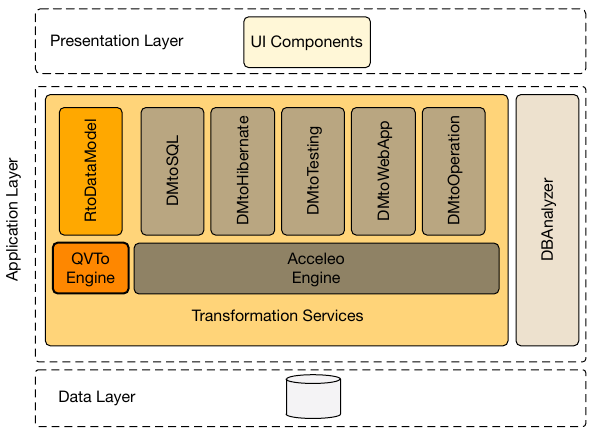
Figure 9. E-MDAV Tool Abstract